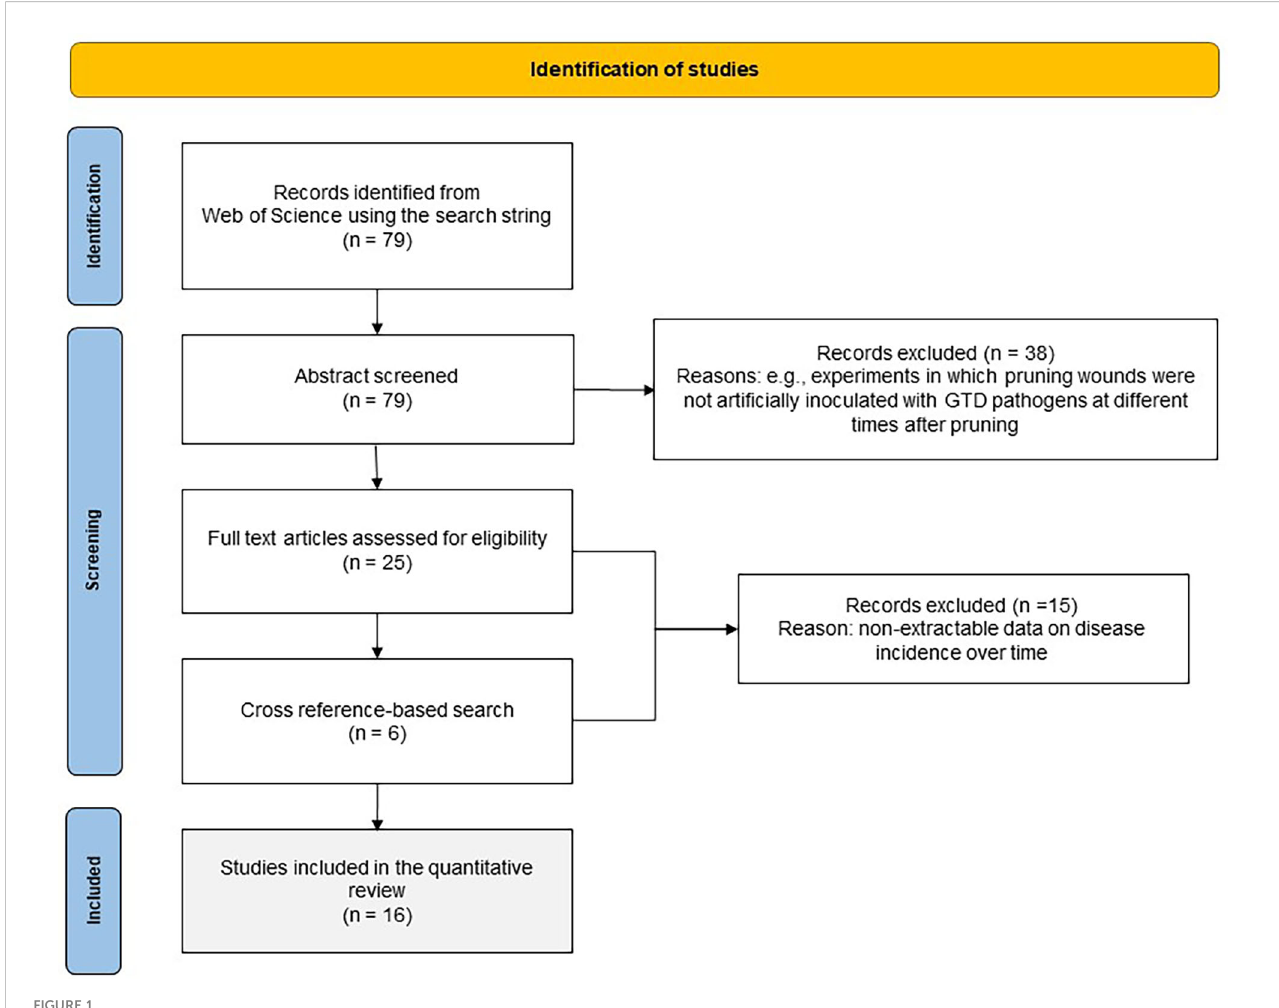
FIGURE 1 PRISMA fl ow diagram showing the procedure used for selection of studies for the quantitative